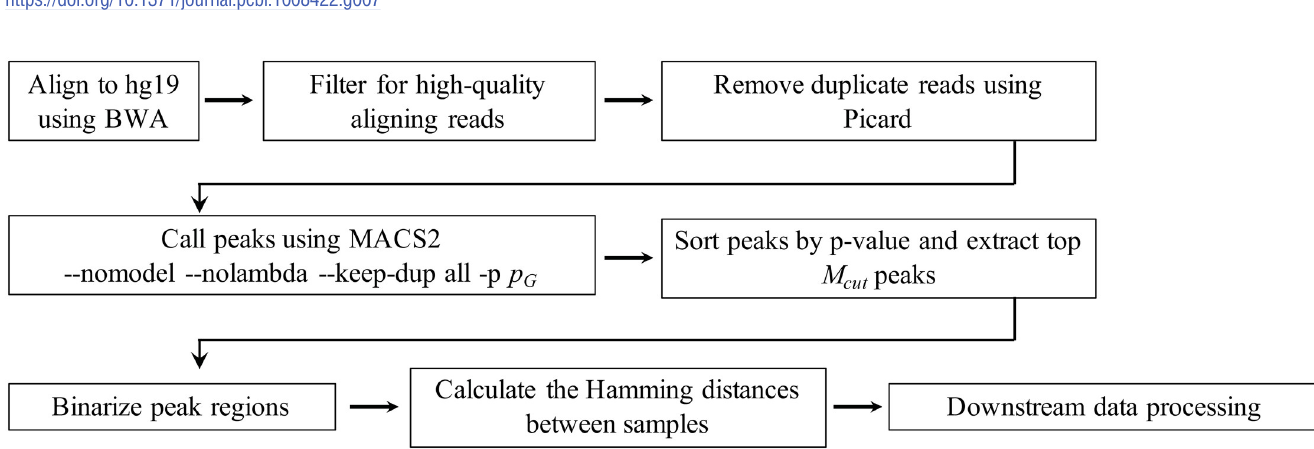
Fig 8. Schematic workflow of our algorithm. See Materials and methods for details.